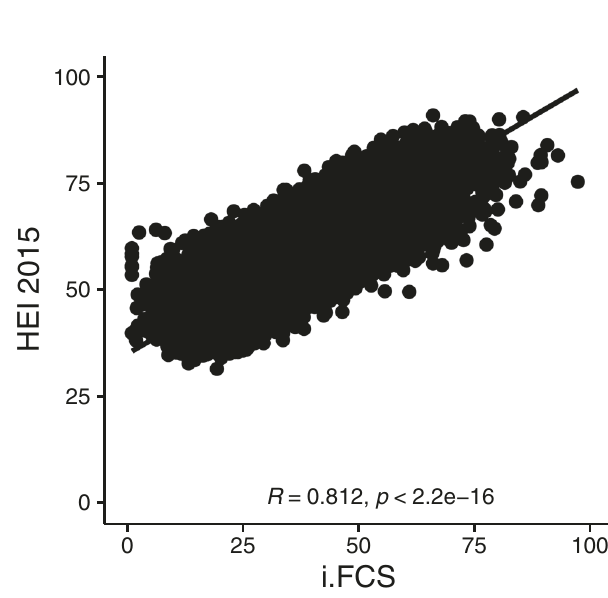
Fig. 3 | Relationship between the Healthy Eating Index (HEI) 2015 and energy- weighted, individual Food Compass Score (i.FCS) among U.S. adults, 1999 – 2018. i.FCS was calculated by taking the energy-weighted mean of the respective score for all foods consumed by that individual reported in up to two24hrrecalls.BlackdotsrepresenteachNHANESrespondent;solidline,theline of best fi t between all NHANES respondents; and R value, the correlation and p -